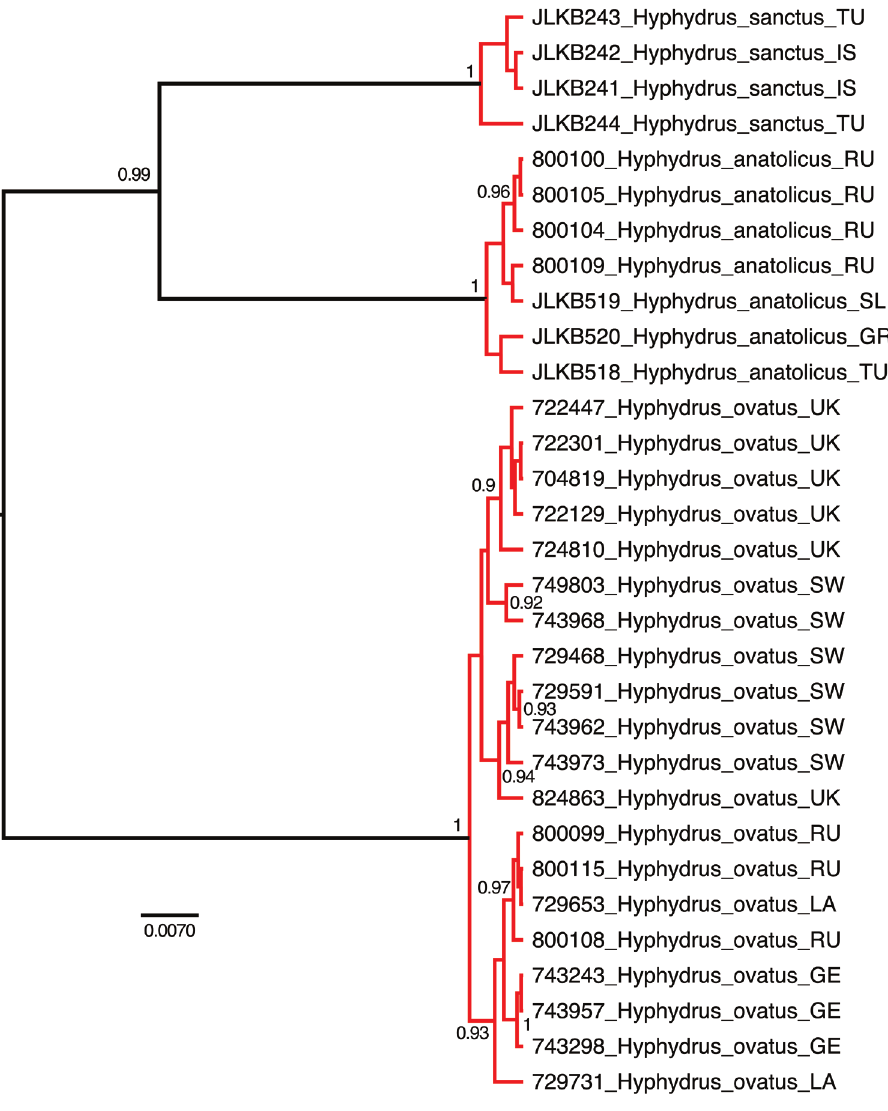
Figure 3. Clock-rooted ultrametric tree from Bayesian analysis with branches coloured according to the GMYC species delimitation analysis. Posterior probability clade support values >0.9 shown. Black branches=speciation events, red braches=within species coalescence events. Country abbreviations as in Figure